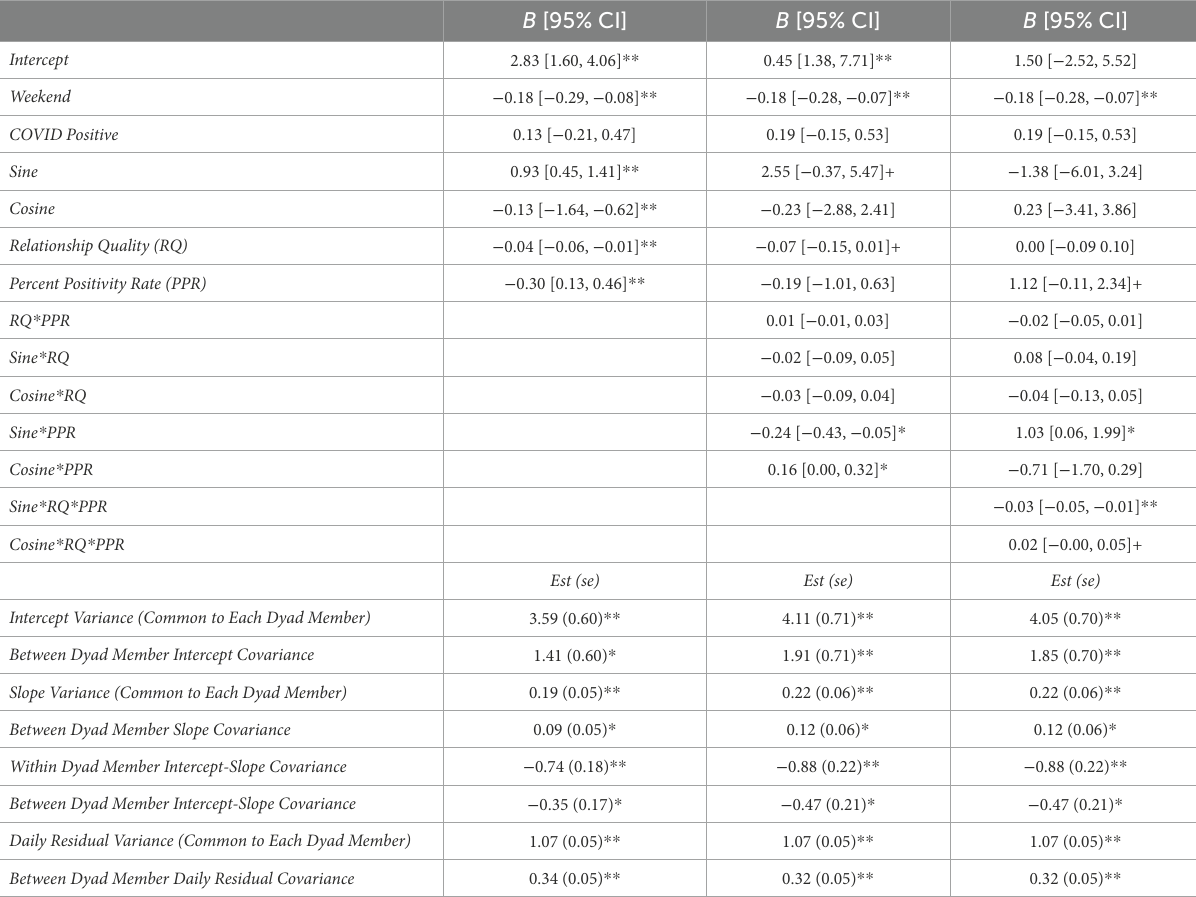
TABLE 2 Estimates for main effects model (column 1), two-way interactions (column 2), and three-way interactions (column 3) predicting daily